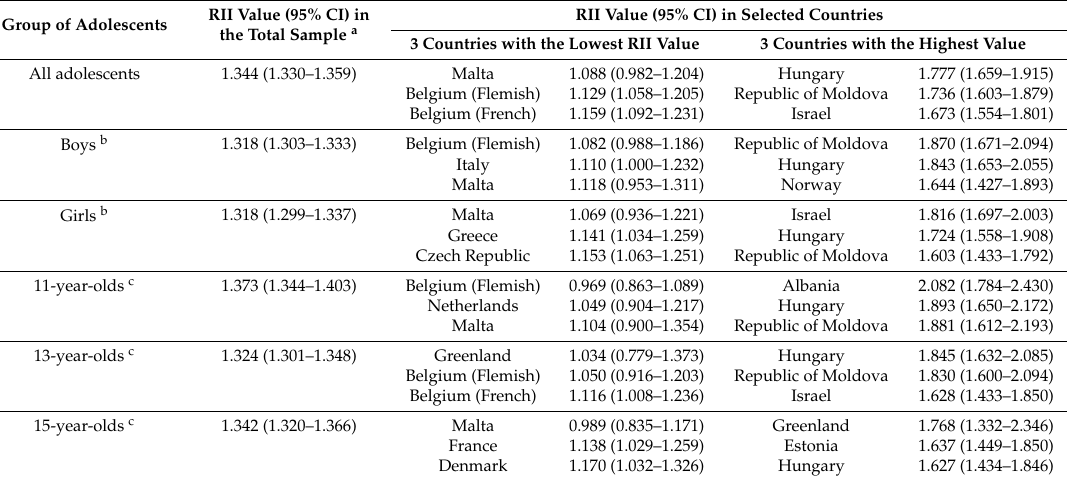
Table 2. Relative Index of Inequality (RII) in life satisfaction in the total sample and in selected countries, by adolescent group. RII Value (95% CI) in RII Value (95% CI) in Selected Countries the Total Sample a 3 Countries with the Lowest RII Value